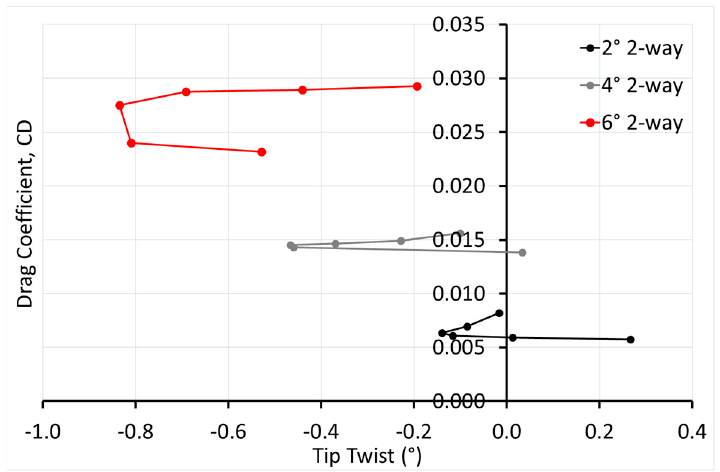
Figure 18. Drag coefficient vs. tip twist angle.